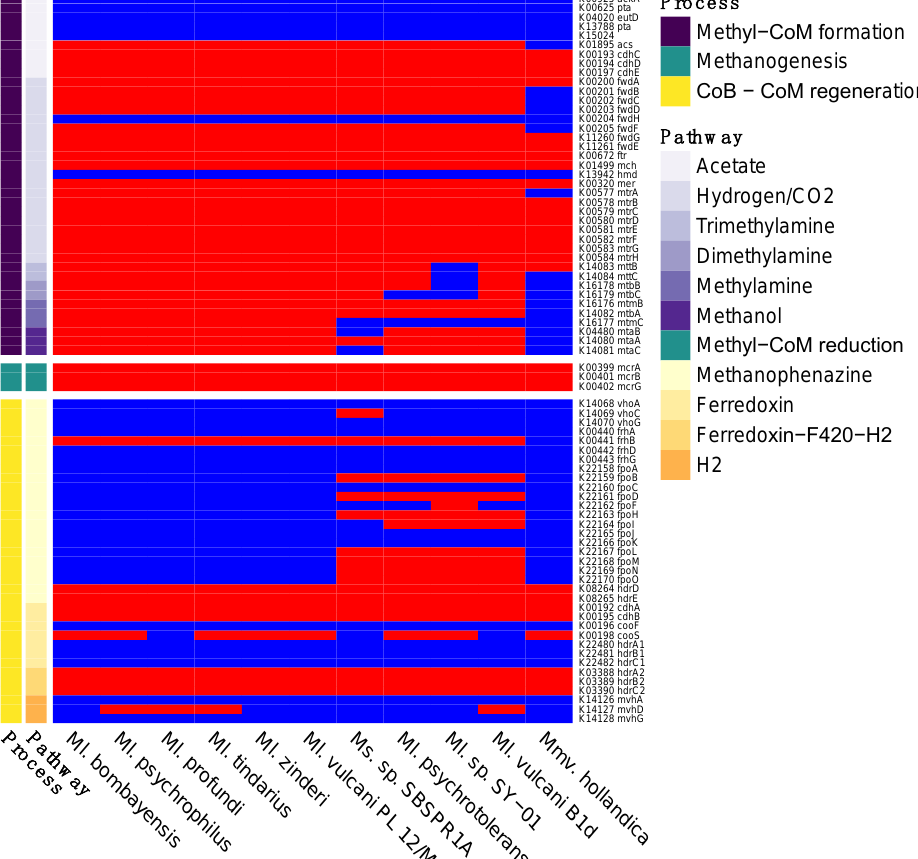
Figure 3. Presence (red) or absence (blue) of genes involved in methanogenesis. Shown here are six different pathways for methyl-CoM formation (Figure S1), the single methane production step of methyl-CoM reduction, and four pathways for coenzyme B (CoB) and coenzyme M (CoM) regeneration. The names of the genes and their KEGG K number assignments are shown. Columns are clustered by KO presence/absence rather than phylogeny.